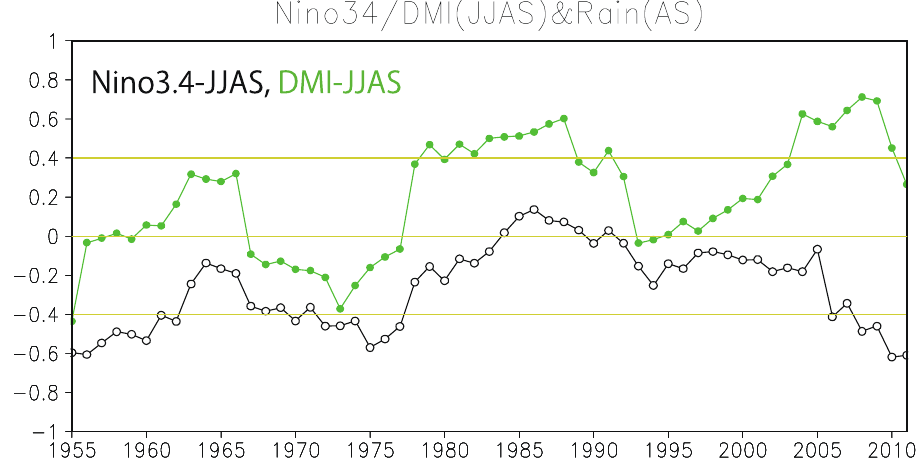
Figure 5 . Interdecadal changes in monsoon–ENSO/DMI relationships. Eleven-year sliding correlation between August–September (AS) rainfall anomaly over northern India (20–30° N, 75–90° E) and June–September (JJAS) Nino 3.4 (black) and Dipole Mode Index (DMI) (green) indices from 1948 to present.